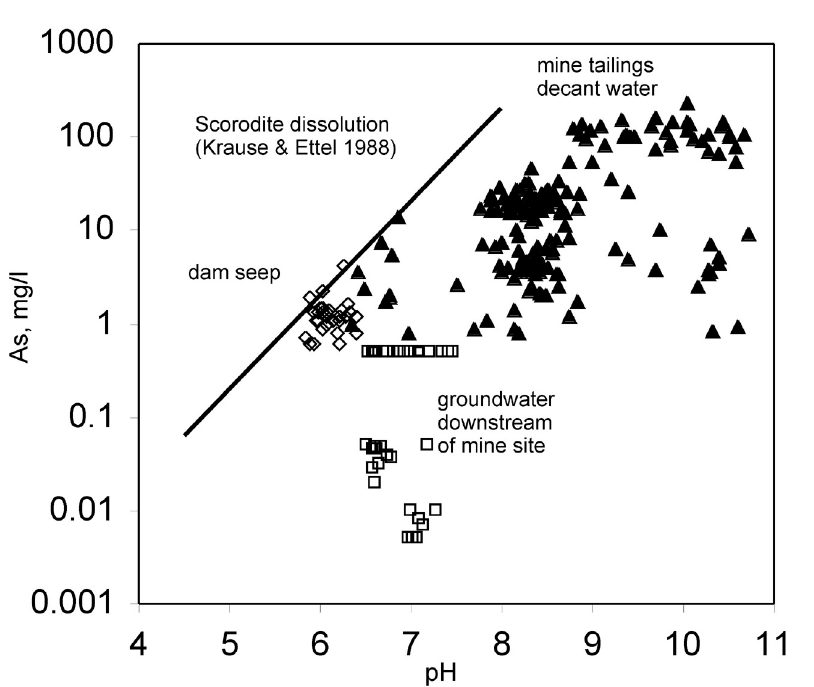
FIGURE 6. Dissolved As concentrations and pH (cf. Fig. 3) of mine waters at the active Macraes mine (Fig. 1), and groundwater immediately downstream in which a plume of mine water can be detected. Row of data at 0.5 mg/l is due to the use of that detection limit for those samples. Maximum dissolved As concentrations resulting from dissolution of scorodite (after Krause and Ettel[21]) is shown with a solid